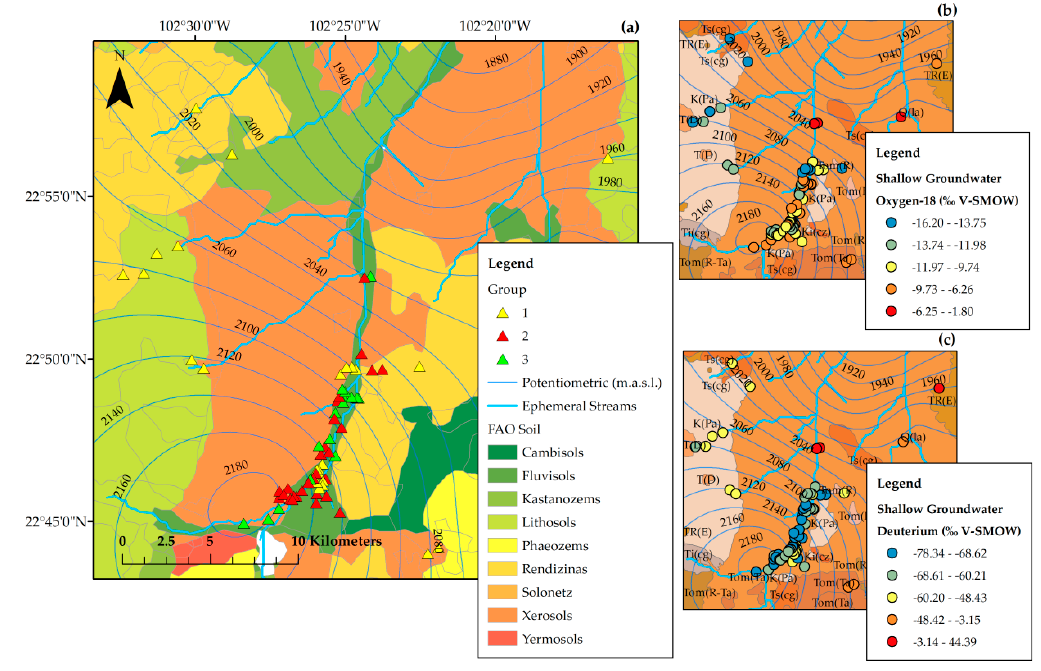
Figure 7. Spatial distribution of the stable isotopic composition of ShGw sampled in the study area ( a ); and spatial distribution of Oxygen-18 ( b ) and Deuterium ( c ).